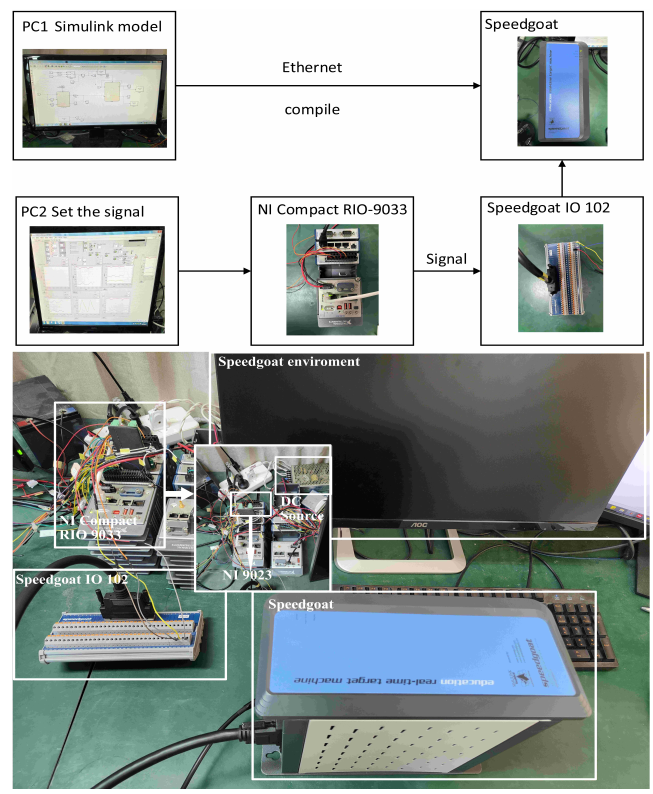
Figure 12. The test